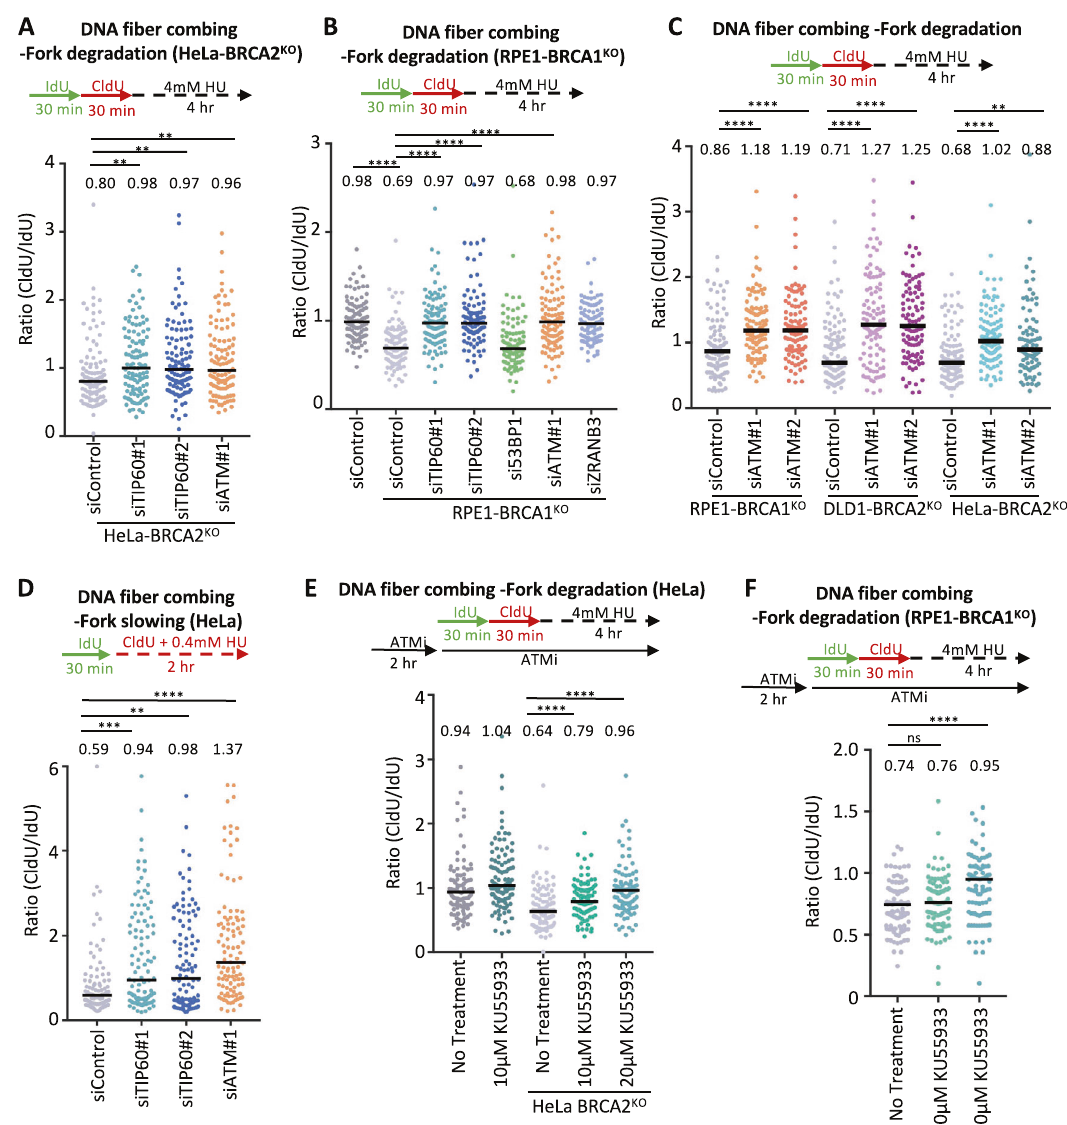
( B ) cells. The ratio of CldU to IdU tract lengths is presented, with the median values marked on the graph and listed at the top. At least 100 tracts were quanti fi ed for each sample. Asterisks indicate statistical signi fi cance (Mann – Whitney test). A schematic representation of the